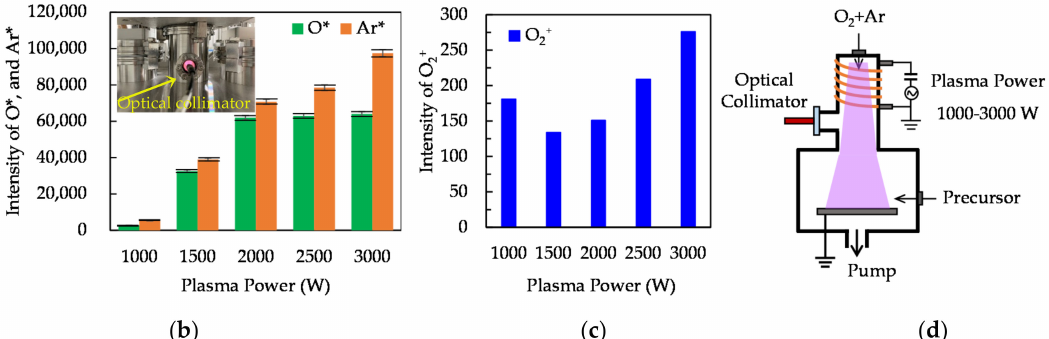
Figure 1. ( a ) Optical emission spectroscopy (OES) spectra, and ( b ) intensity variation of O*, Ar*, and ( c ) O 2+ with increased power from 1000 to 3000 W in plasma-enhanced atomic layer deposition (PEALD) SnO 2 thin films deposition. The inserted image is the photo of glow discharge at 1500 W. ( d ) The schematic diagram for the ionization of Ar and O 2 gas in PEALD process equipped with the OES optical